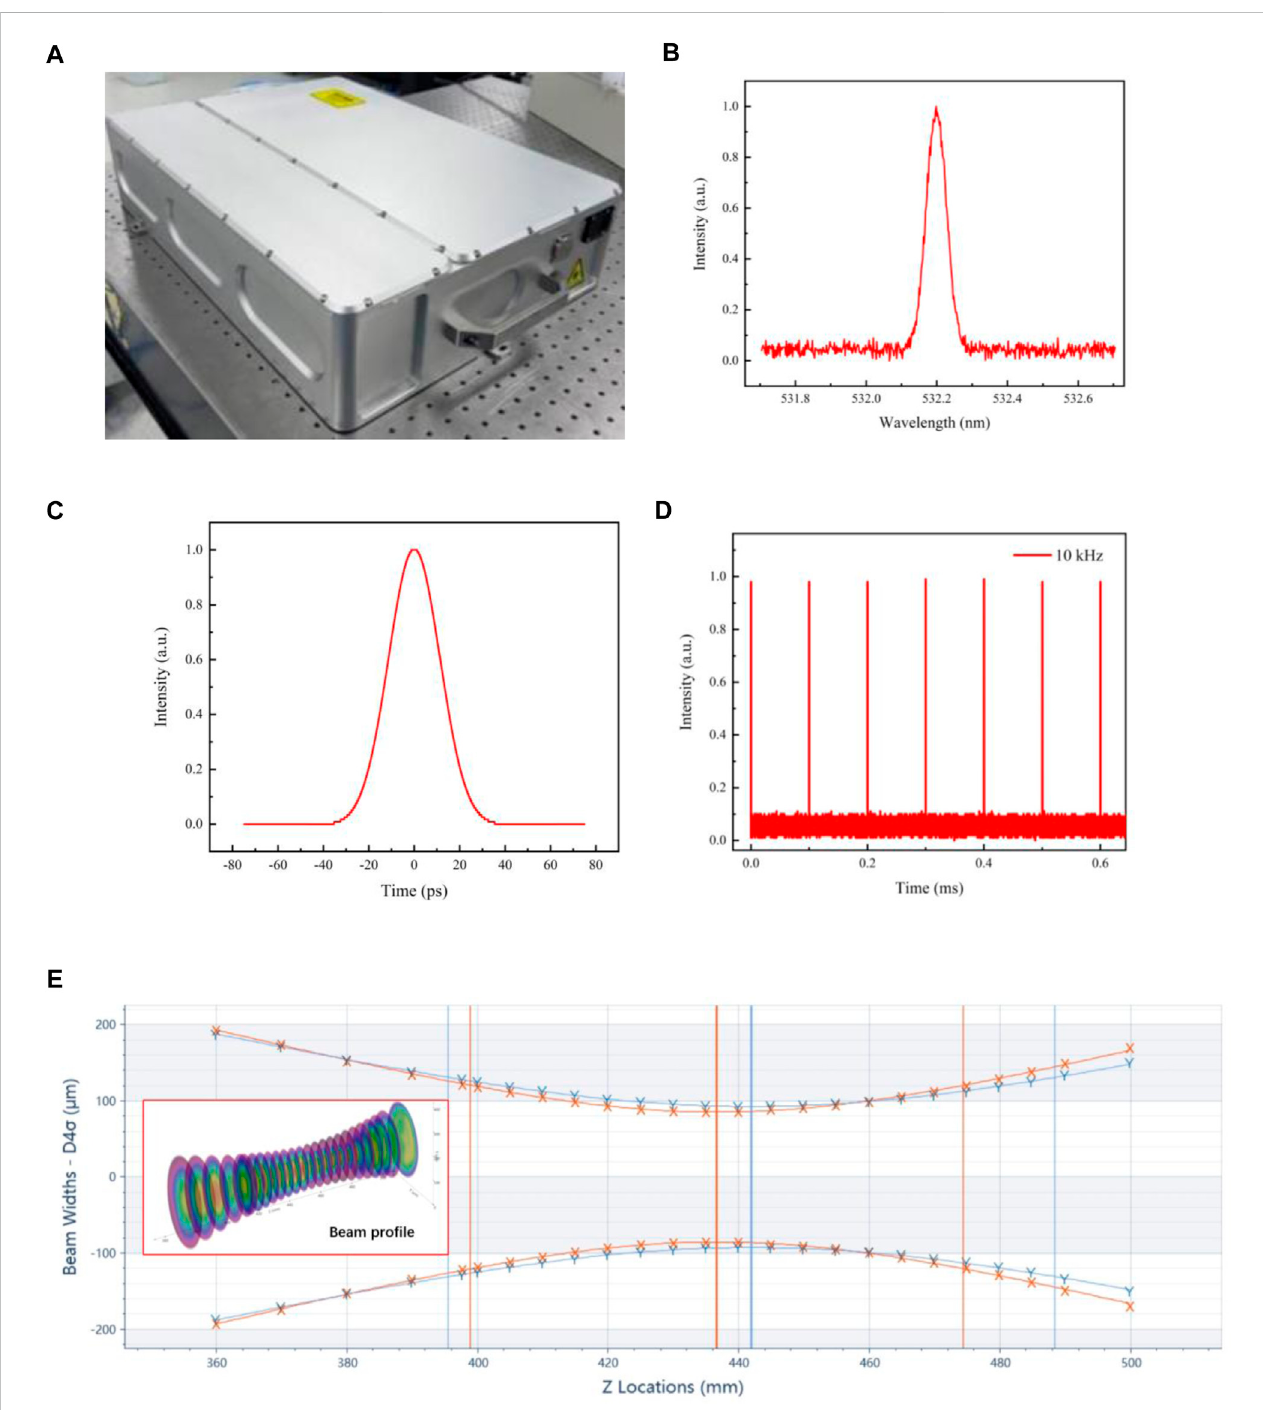
FIGURE 2 Compilation of output characteristics of the green laser. (A) Encapsulated lasers; (B) Normalized wavelength spectrum of the ampli fi ed laser output; (C) Characteristic of asingle output pulse with an autocorrelation trace; (D) Normalizedpulse characteristics of theoutput (E) plotof the focusing characteristics of the output beam (inset: beam pro fi